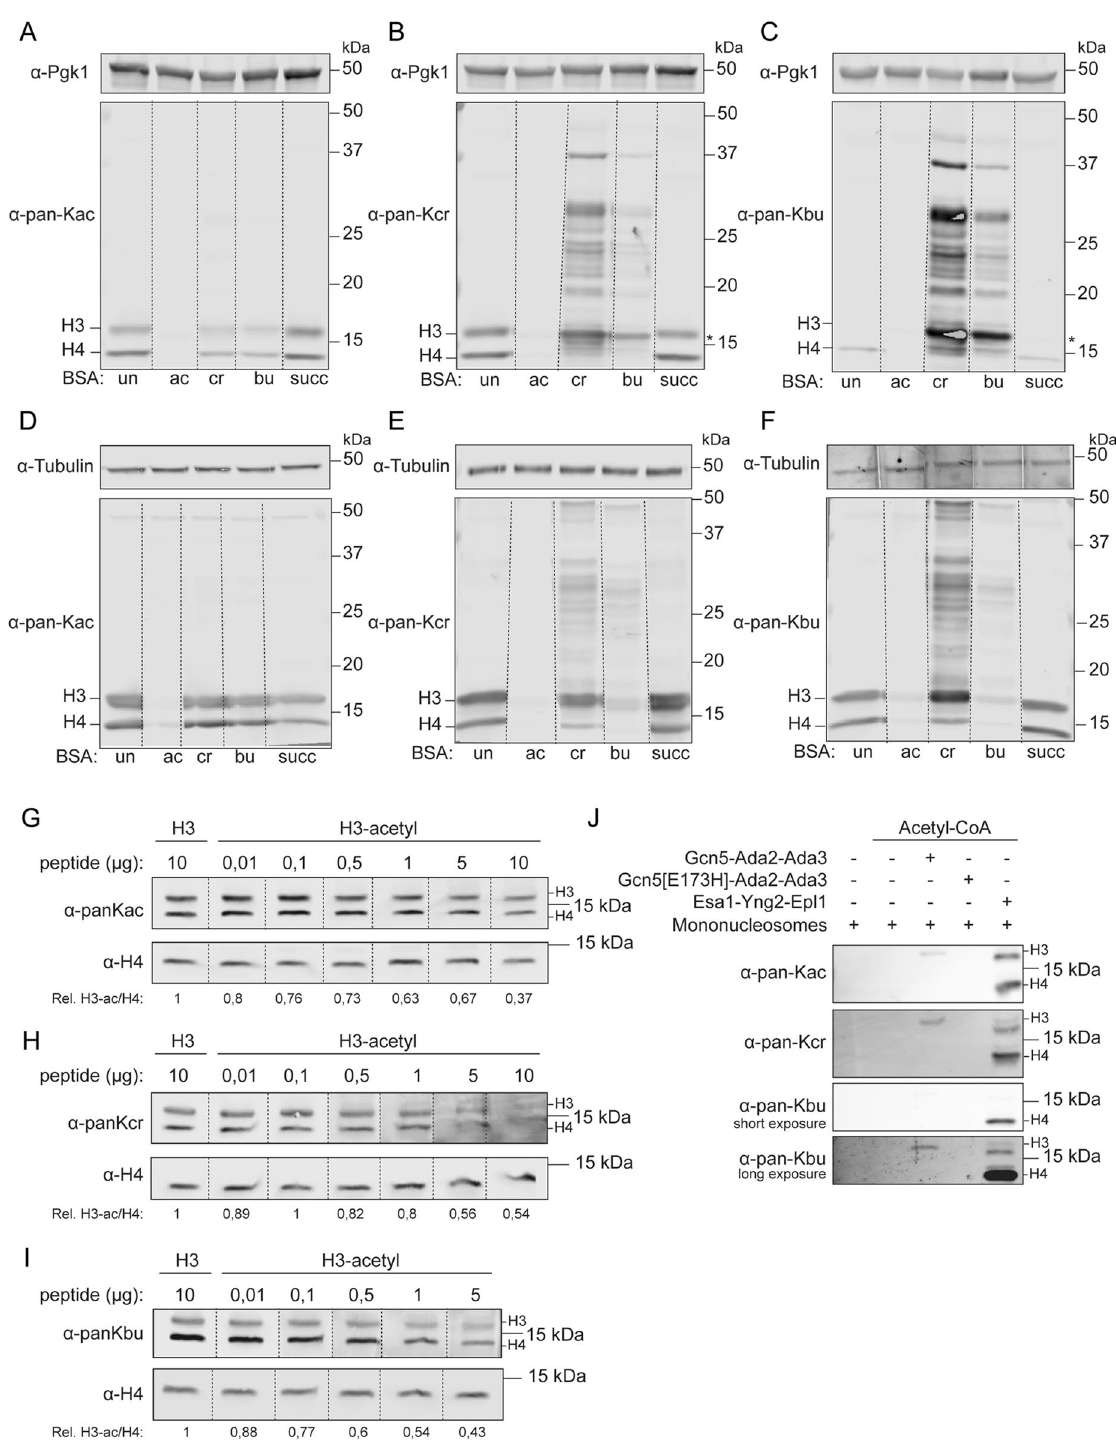
Figure 3. Western blot analysis of pan-K-acyl antibodies with BSA competitors on yeast and HeLa cell extracts. Whole-cell extracts of wild-type yeast cells ( A – C ) and HeLa cells ( D – F ) were immunoblotted with the indicated antibodies in the presence of (modified) BSA. All lanes contain the same yeast or HeLa whole-cell extract. 0.5 µg BSA per microliter of antibody was added. Asterisk highlights background band. Whole-cell extracts of wild-type yeast cells ( G – I ) were immunoblotted with the indicated antibodies in the presence of (acetylated) H3 peptide. All lanes contain the same whole-cell extract. Below the blots is a quantification of the acylation signal over H4 of at least two independent experiments. ( J ) Western blot analysis of in vitro histone acetyltransferase assay with recombinant wild-type and catalytic-dead (Gcn5-E173H) ADA complex and wild-type Piccolo NuA4 complex immunoblotted with the indicated